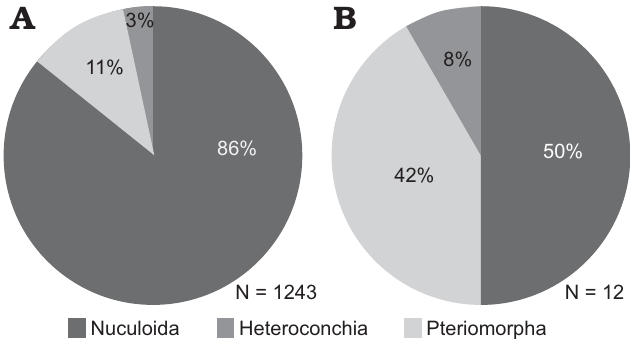
Fig. 8. Number of individual bivalves ( A ) and bivalve species ( B ) dis- tributed within orders/infraclasses in the Areyonga Gorge and Petermann Creek